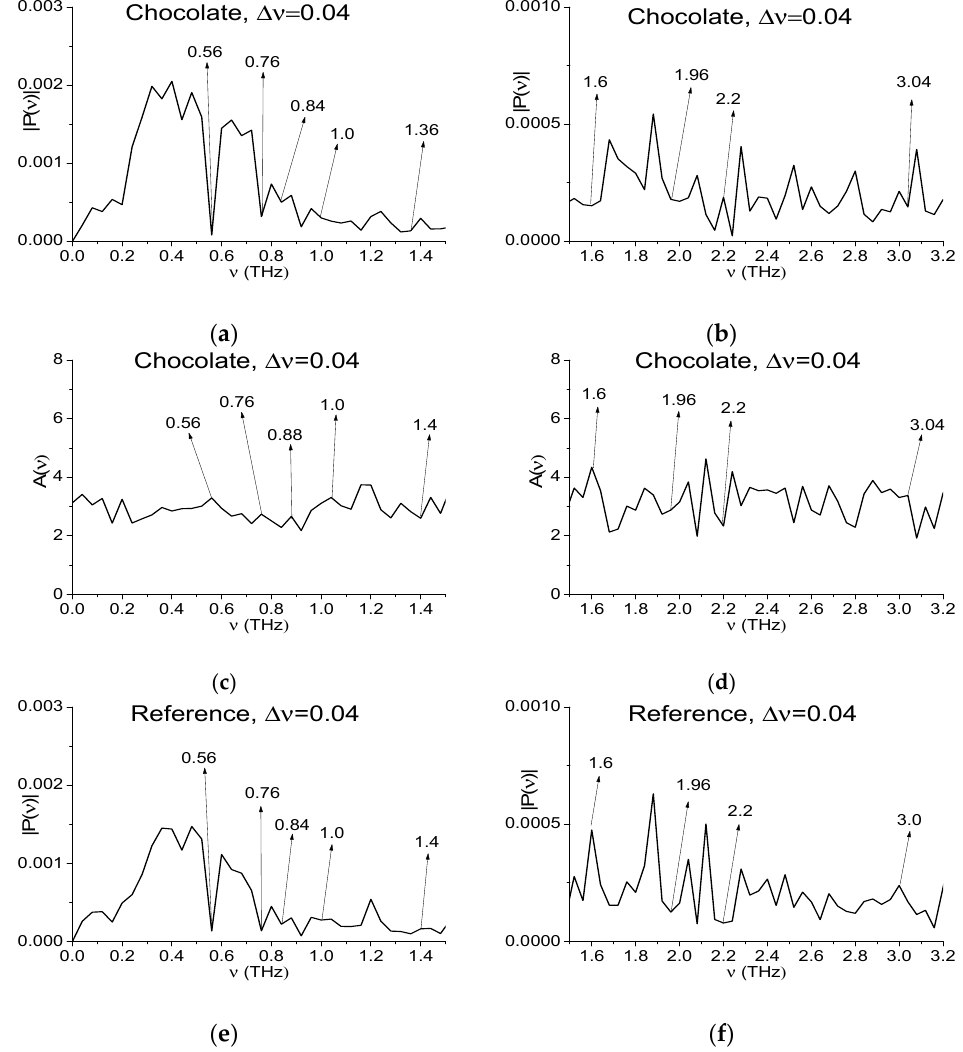
Figure 4. Fourier spectrum of the signal Chocolate ( a , b ), absorbance ( c , d ) and Reference spectrum ( e , f ) in the frequency ranges ν = [0, 1.5] THz ( a , c , e ) and [1.5, 3.2] THz ( b , d , f ) calculated with spectral resolution Δ ν = 0.04 THz.